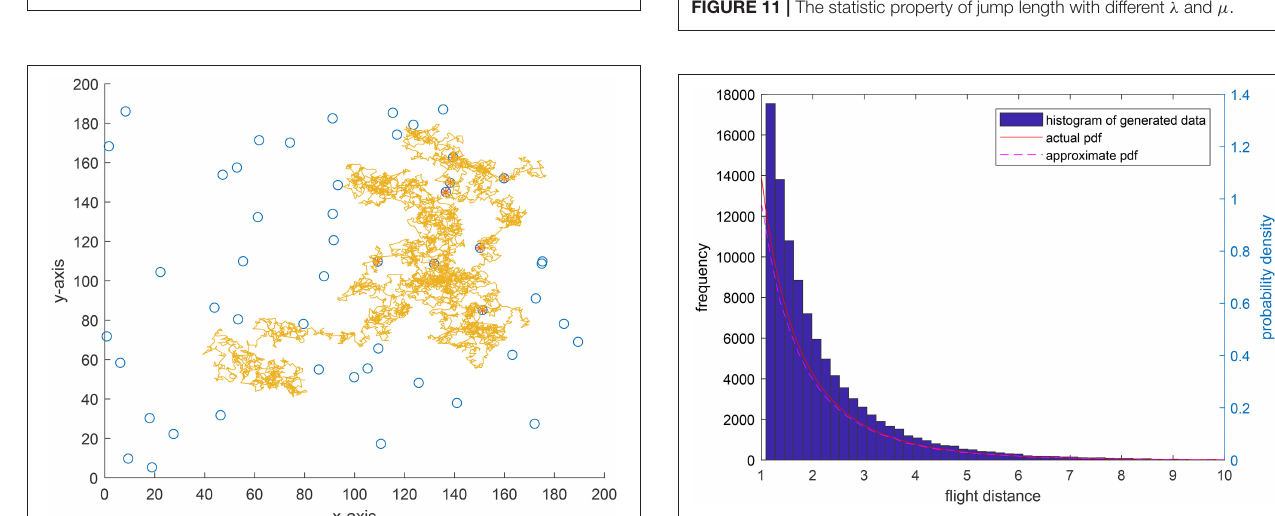
FIGURE 11 | The statistic property of jump length with different λ and µ .